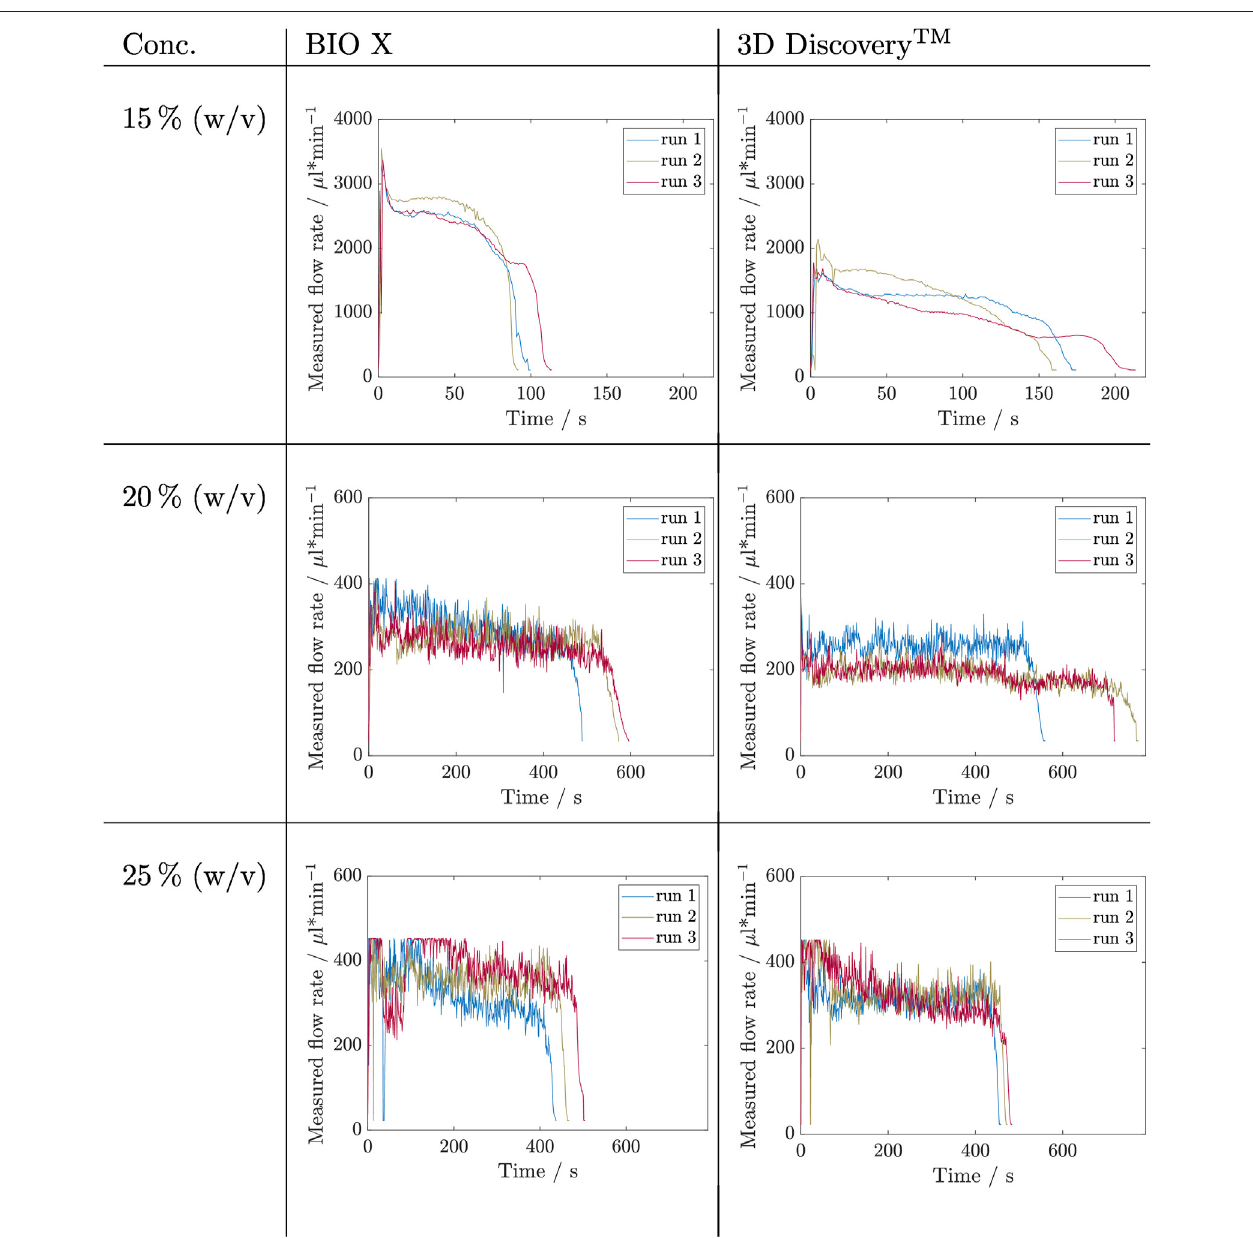
FIGURE 5| Results of fi lling level in fl uence investigation forinks containingKolliphor concentrationsof 15, 20, and 25% (w/v) by measuring the fl owrate during the complete emptying of a cartridge. This experiment was carried out in triplicates ( n run = 3) for each concentration and on two bioprinter systems, namely BIOX and 3D Discovery ™ . The respective set pressures are listed in Table 3